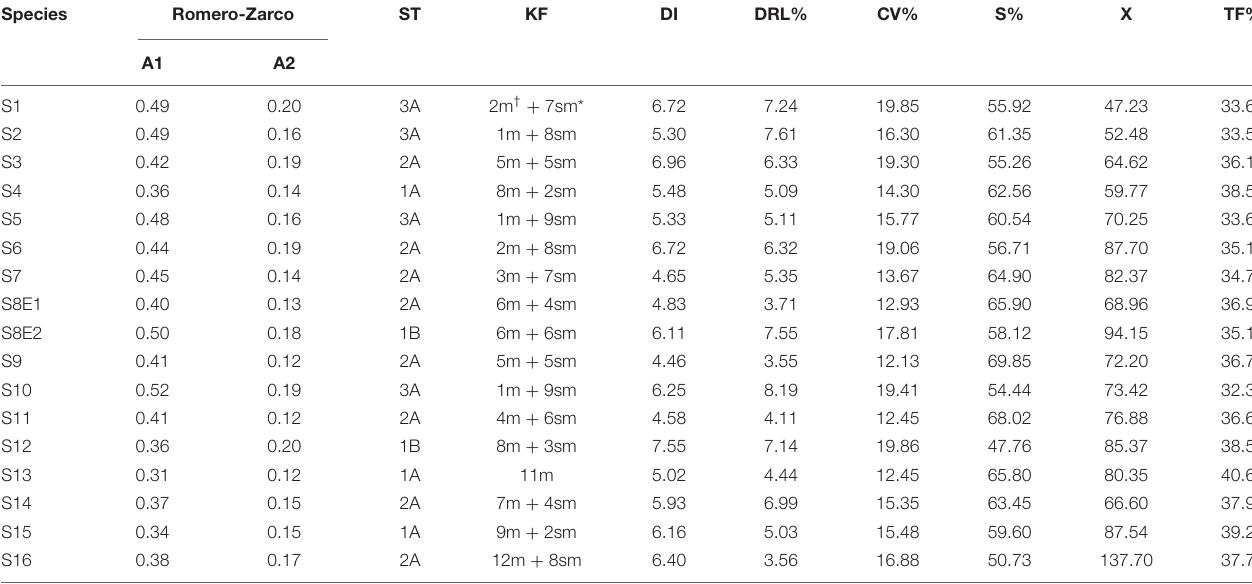
TABLE 2 | The karyotypic symmetry formula for Pimpinella species (ST: Stebbins’ type; KF: Karyotype formula). Species